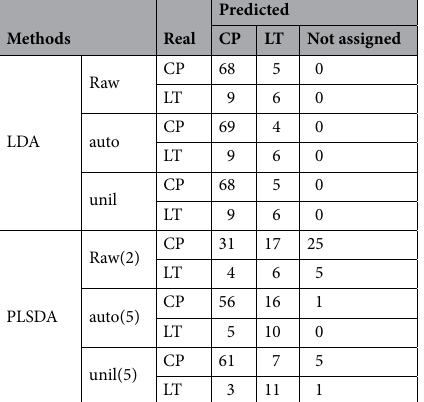
Table 5. The classification results of LDA and PLSDA on electronic tongue data. auto stands for Autoscaling; unil stands for Unitlength; CP is short for Codonopsis pilosula (Franch.) Nannf ; LT is short for Codonopsis